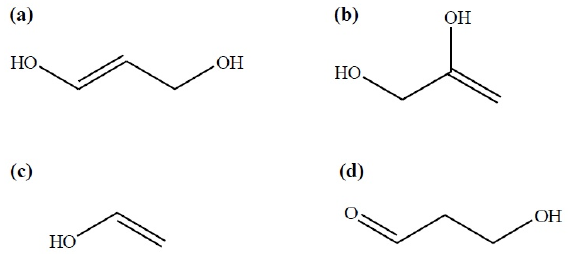
Figure 1. Intermediary compounds in glycerol dehydration: ( a ) 1,3-dihydroxypropene; ( b ) 2,3- dihydroxypropene; ( c ) vinyl alcohol and; ( d ) 3-hydroxypropanal (keto-isomer of 1,3-DHP) according to